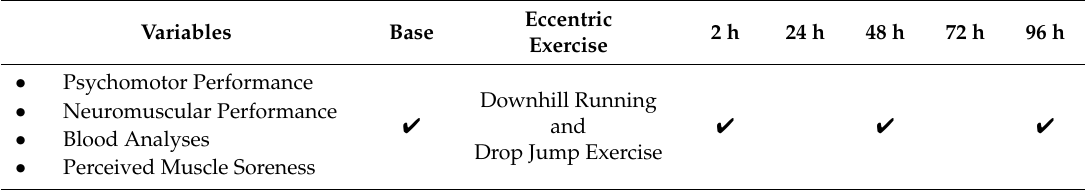
Table 1. The time points of